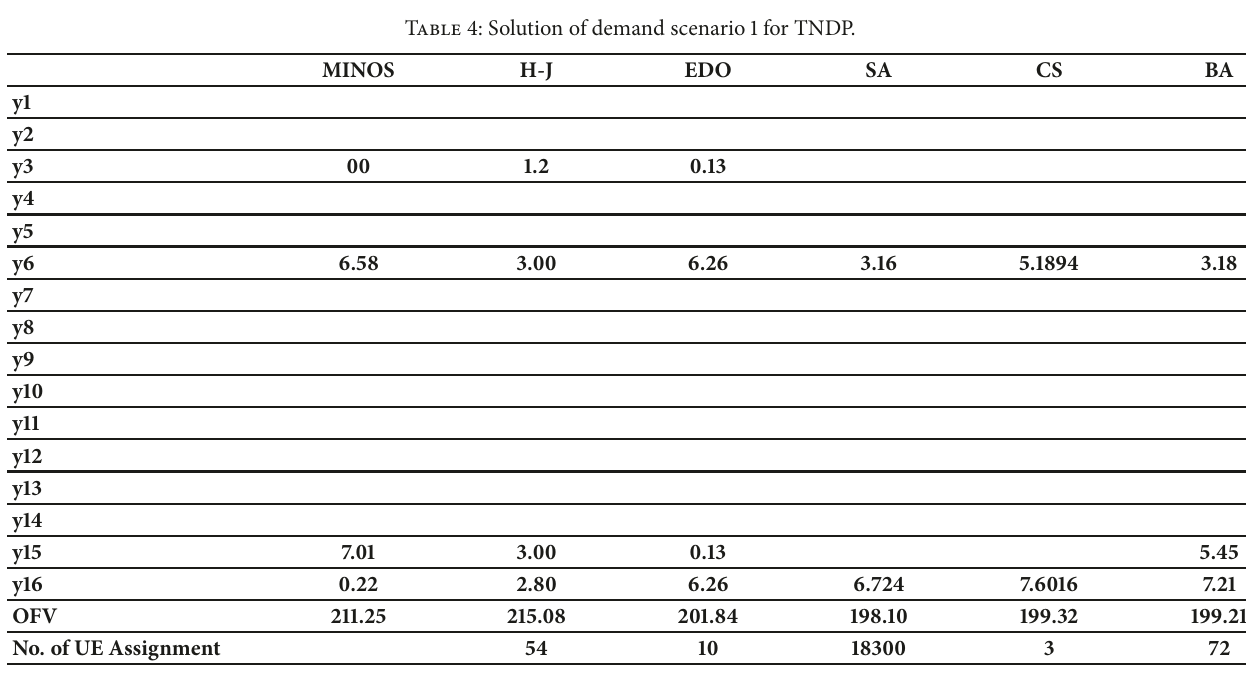
Table 4: Solution of demand scenario 1 for TNDP.